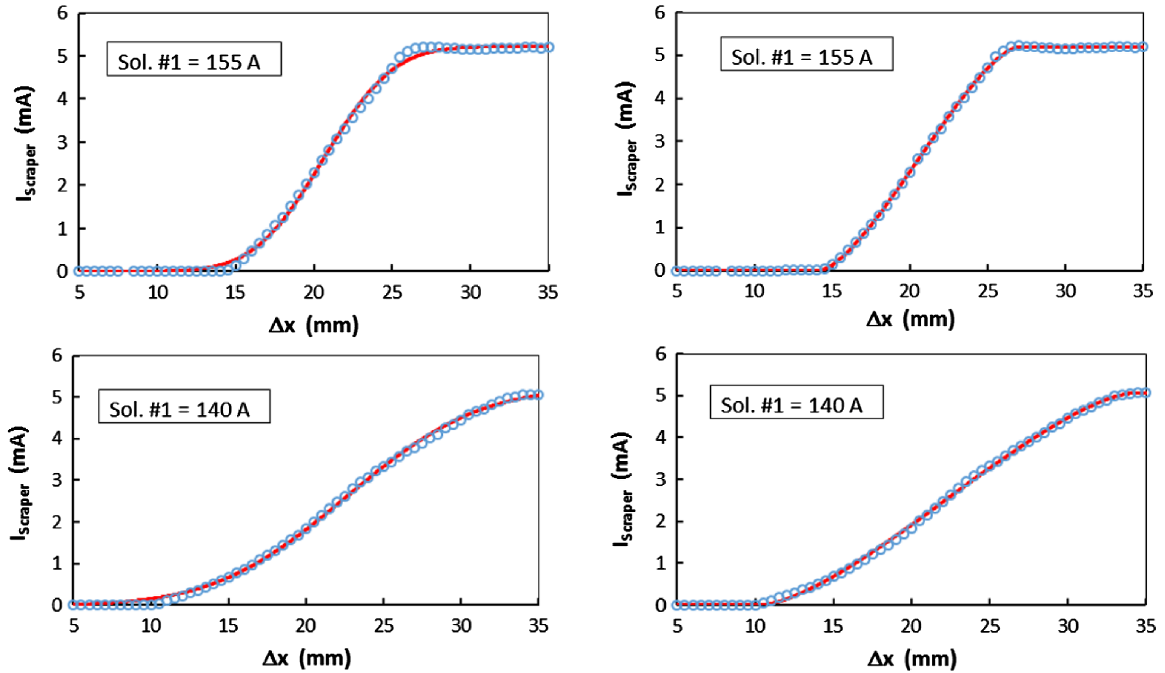
FIG. 10. 1D beam profiles recorded with the “ right ” scraper (horizontal displacement). Top row: For solenoid #1 ¼ 155 A; bottom row: For solenoid #1 ¼ 140 A. The data points are the blue circles. In red are fits from an analytical formulation assuming that the beam current density distribution is either Gaussian (left column) or uniform (right column).